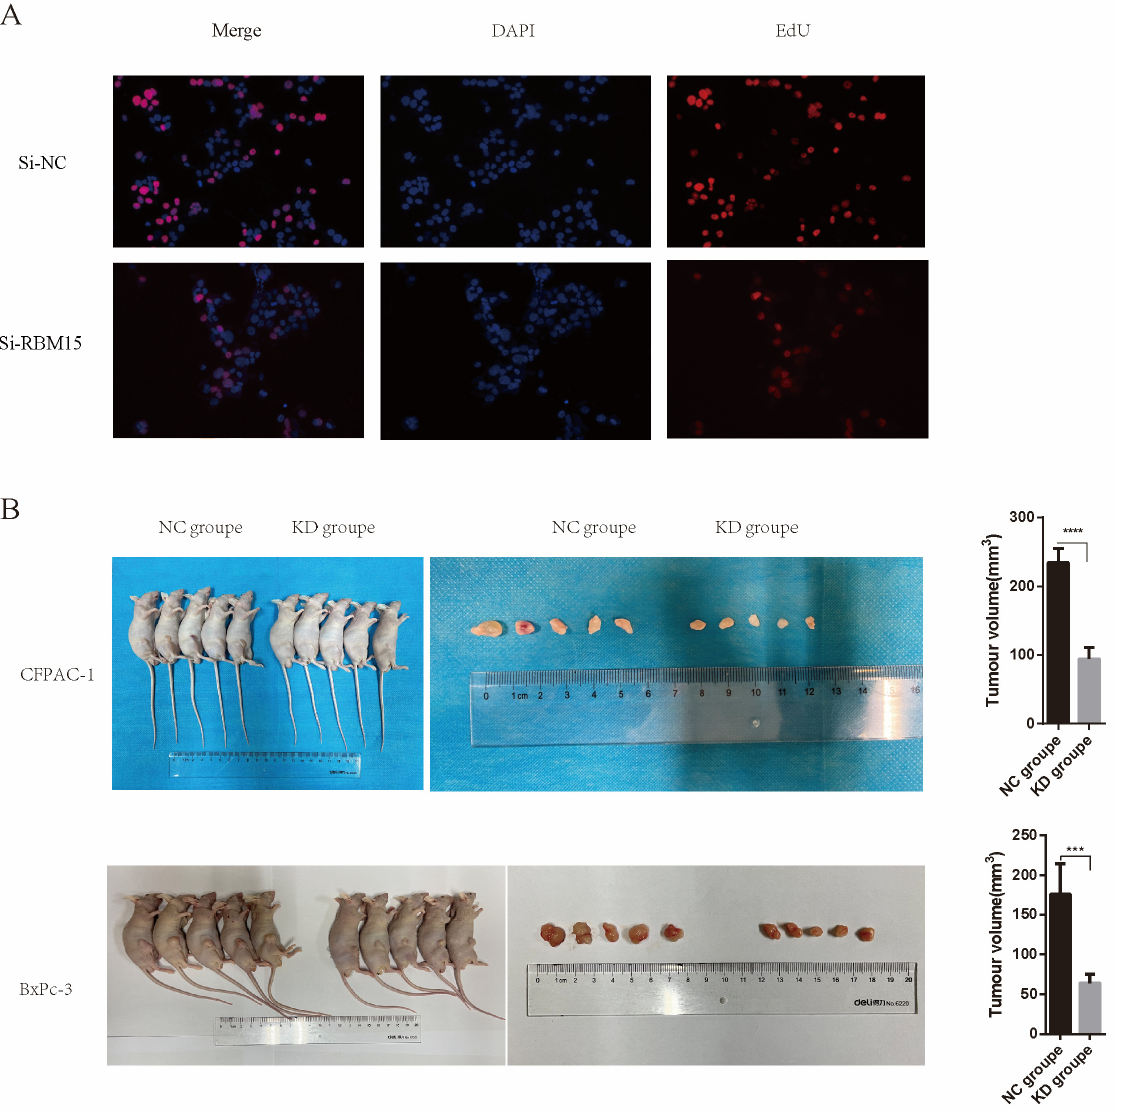
Figure 8. ( A ) EdU test. ( B ) Tumor volumes of different groups in a subcutaneous tumorigenesis model in nude mice (*** p < 0.001; **** p < 0.0001).